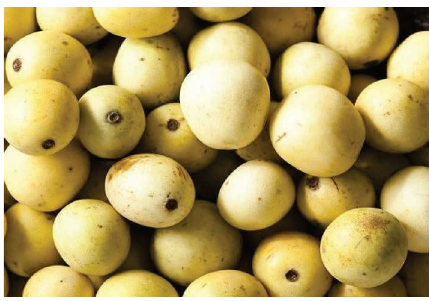
Figure 2: Phenotype of mature Sclerocarya birrea fruit.